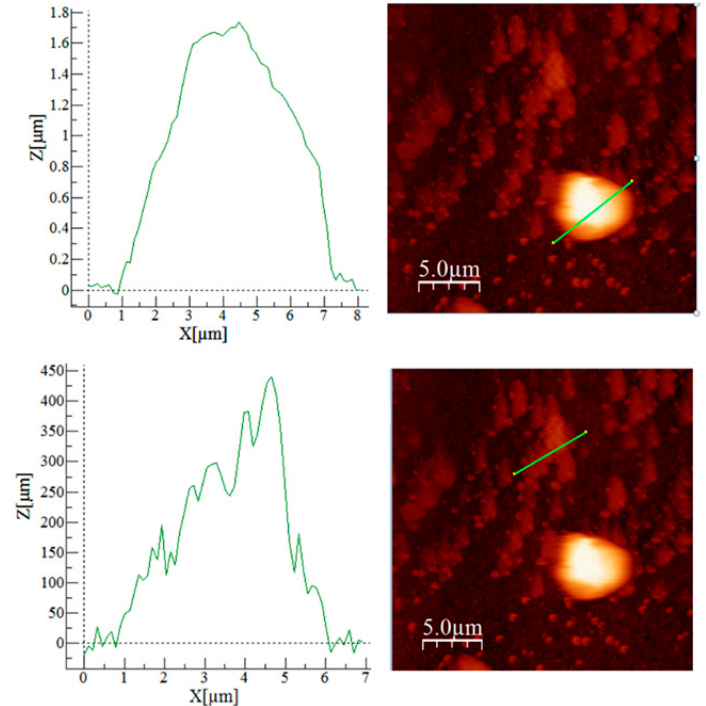
Figure 3. Atomic force microscopy (AFM) image on two selected zones—green lines.